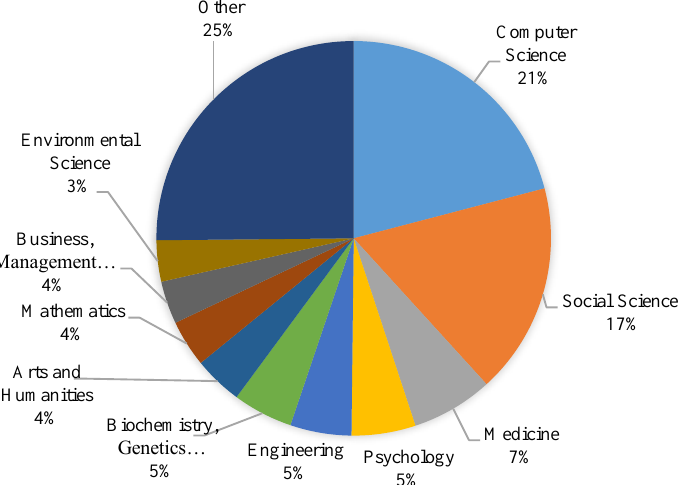
Figure 3. Structure of Publications by Fields of Knowledge of the “Open Science” Research Field in Scopus Source: Compiled by the authors using Scopus data (Scopus,